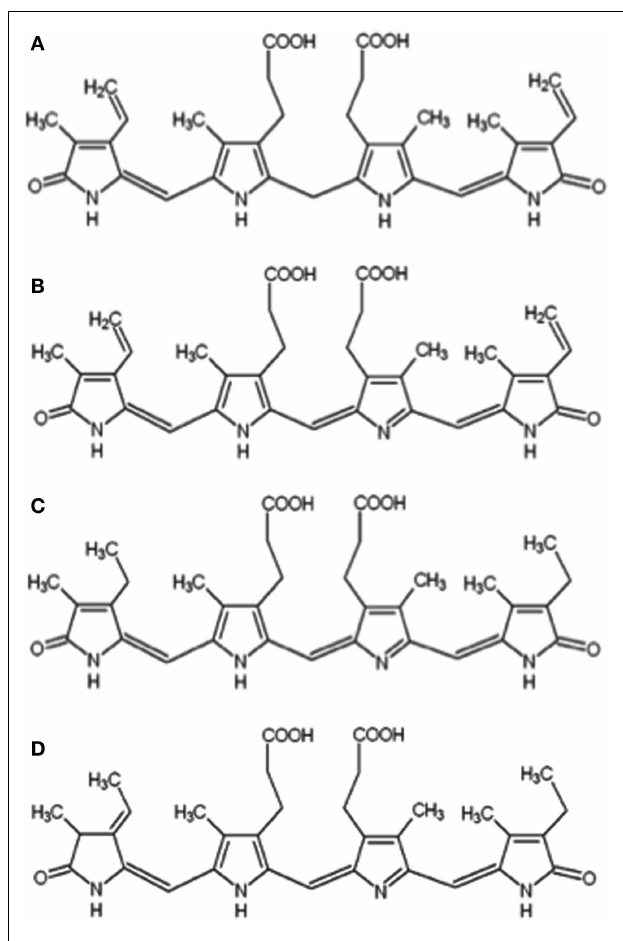
FIGURE 1 | Chemical structures of bilirubin IX α (A), biliverdin IX α (B), mesobiliverdin IX α (C), and phycocyanobilin